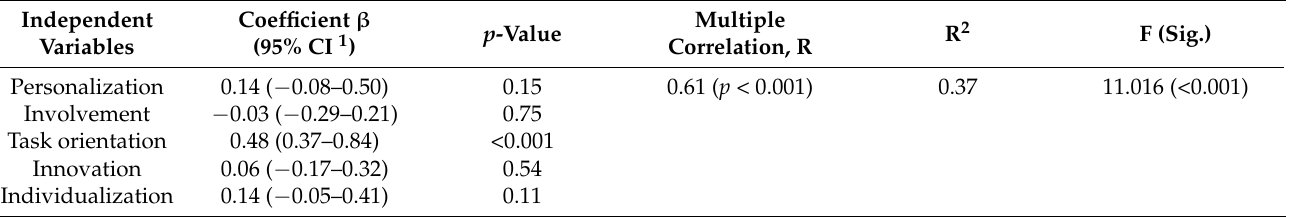
Table 5. Multiple linear regressions with the Satisfaction scale as the dependent variable and the other Actual-CLEI scales as